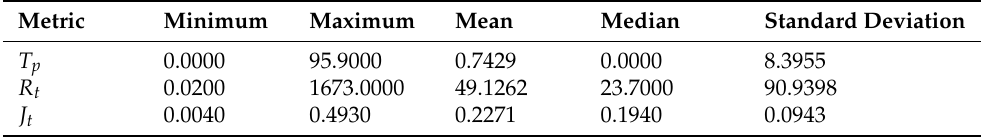
Table 4. Descriptive statistics for T p , R t and J t (over 900 samples) for the HTTP DDoS flooding attack